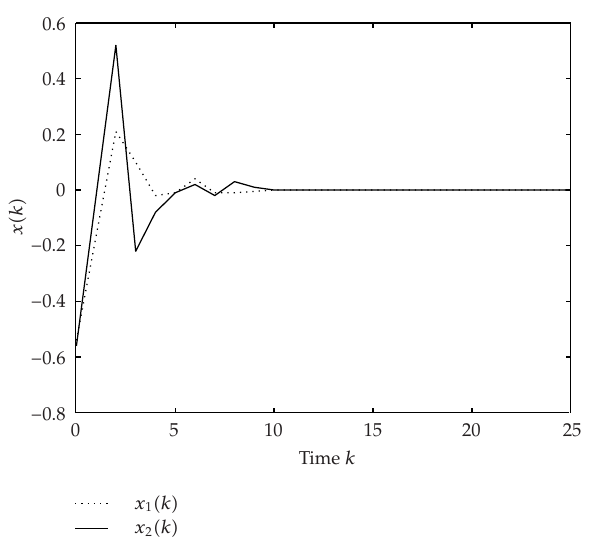
Figure 5: State response of the closed-loop switched discrete-time systems.